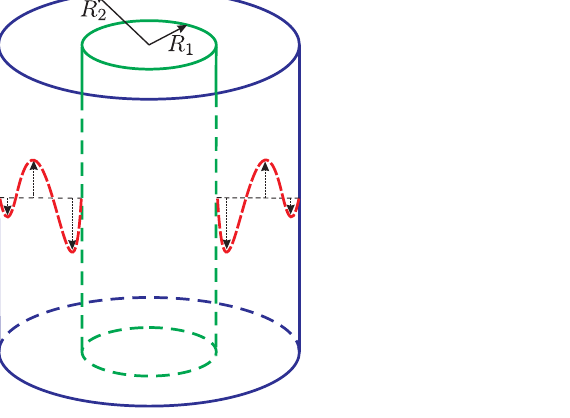
Figure 1. Sketch of the domain of the flow. The base flow velocity is shown in red. Convective flow in the annulus formed by the cylinders is caused by two factors: (a) different constant temperatures ± T 0 of the walls r = R and r = 1, respectively, that cause a temperature gradient in the radial direction and (b) heat release due to chemical reaction that takes place in the fluid. Internal heat sources generate convection in the vertical direction. Here R = R 1 / R 2 , r = ˜ r / R 2 . The distribution of the density of the heat sources follows the Arrhenius’ law